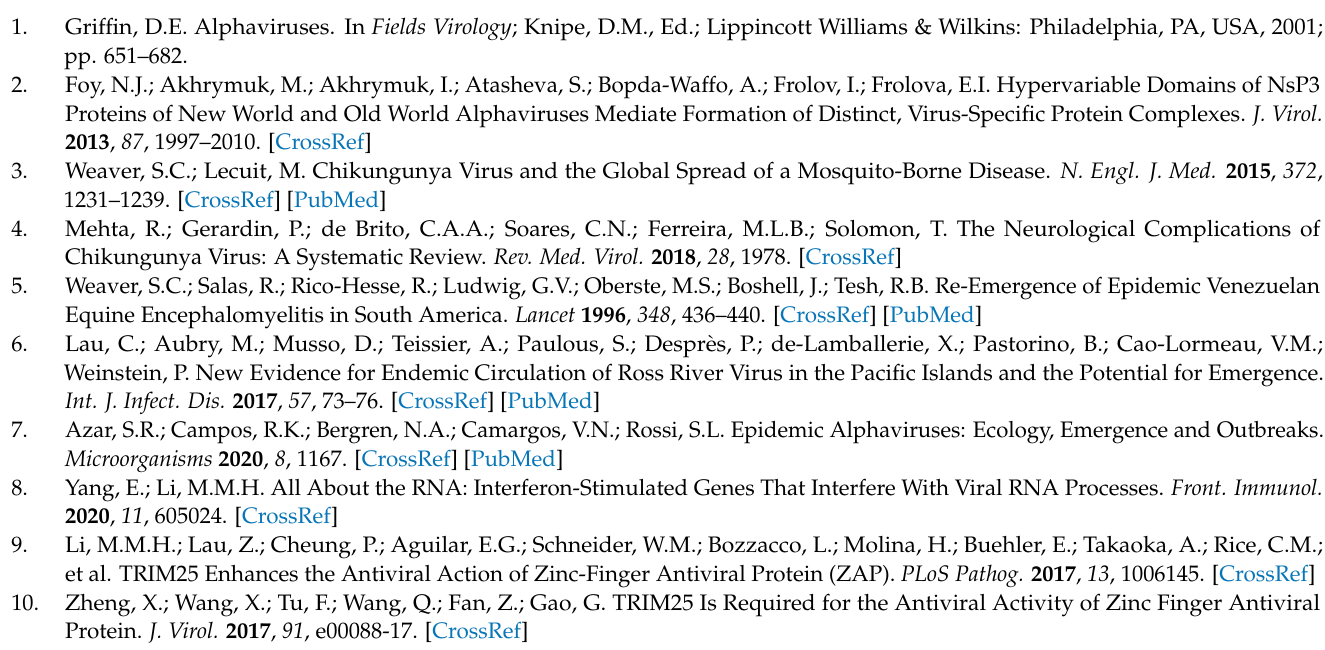
RNA; Figure S2: Pre-treatment with WT and ZAP KO 293T cells with IFN prior to SINV infection; Figure S3: Alphavirus production shows differential sensitivity to basal endogenous ZAP in 293T cells; Figure S4: Alignments of CpG-correlated windows; Figure S5: Quantifications of ZAPS and ZAPL binding to CpG-correlated window 1 RNA and CpG-correlated window 1 mutant RNA; Table S1: Primers for generation of EGFP-expressing CHIKV vaccine strain 181/clone 25; Table S2: Primers to generate CpG-correlated window DNA templates for T7 transcription; Table S3: qPCR primers; Table S4: CpG and UpA dinucleotide contents of CpG-correlated